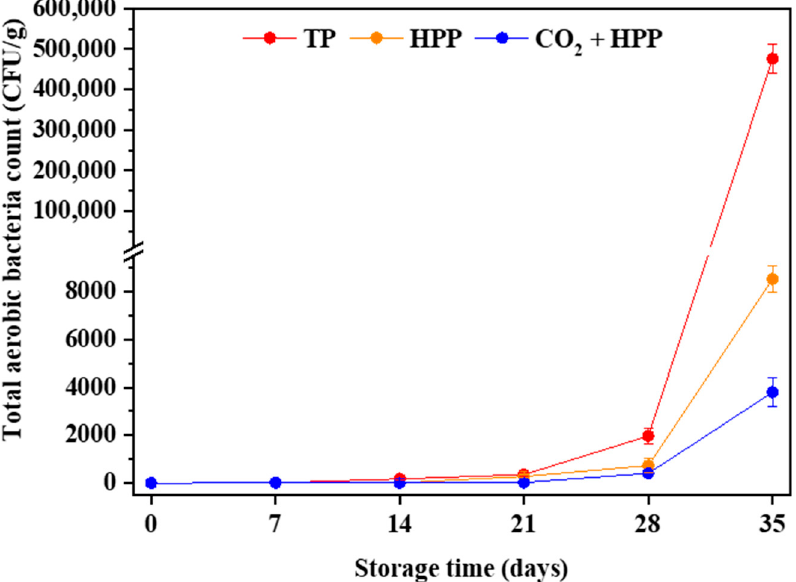
Figure 2. Effects of TP (95 °C, 60 min), HPP (600 Mpa) and CO 2 + HPP (600 Mpa) treatments on total aerobic bacteria counts of DFPs during storage.